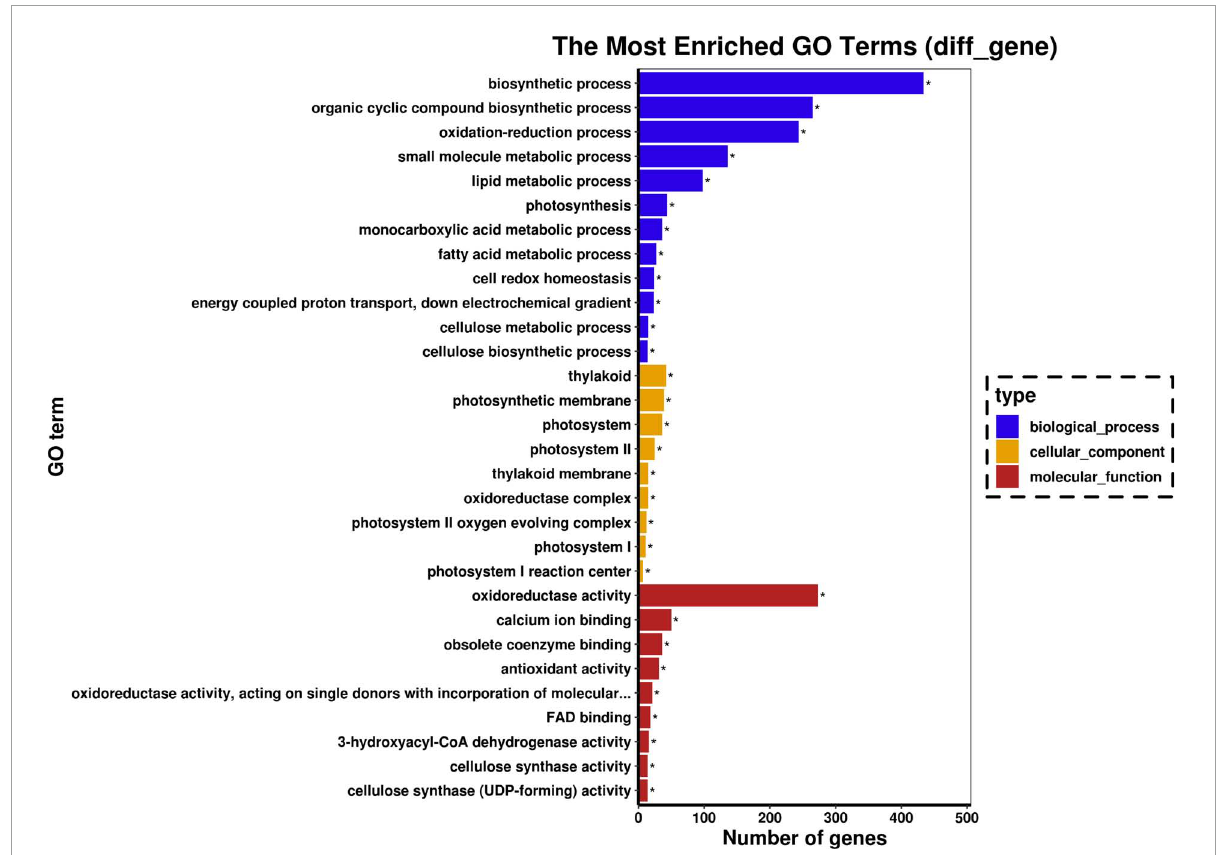
FIGURE3 Gene ontology (GO) analysis for significant DEGs. Graphical representation of numbers of DEGs enriched in biological process, cellular component, and molecular function GO-terms. The symbol “*” represents the significantly enriched GO